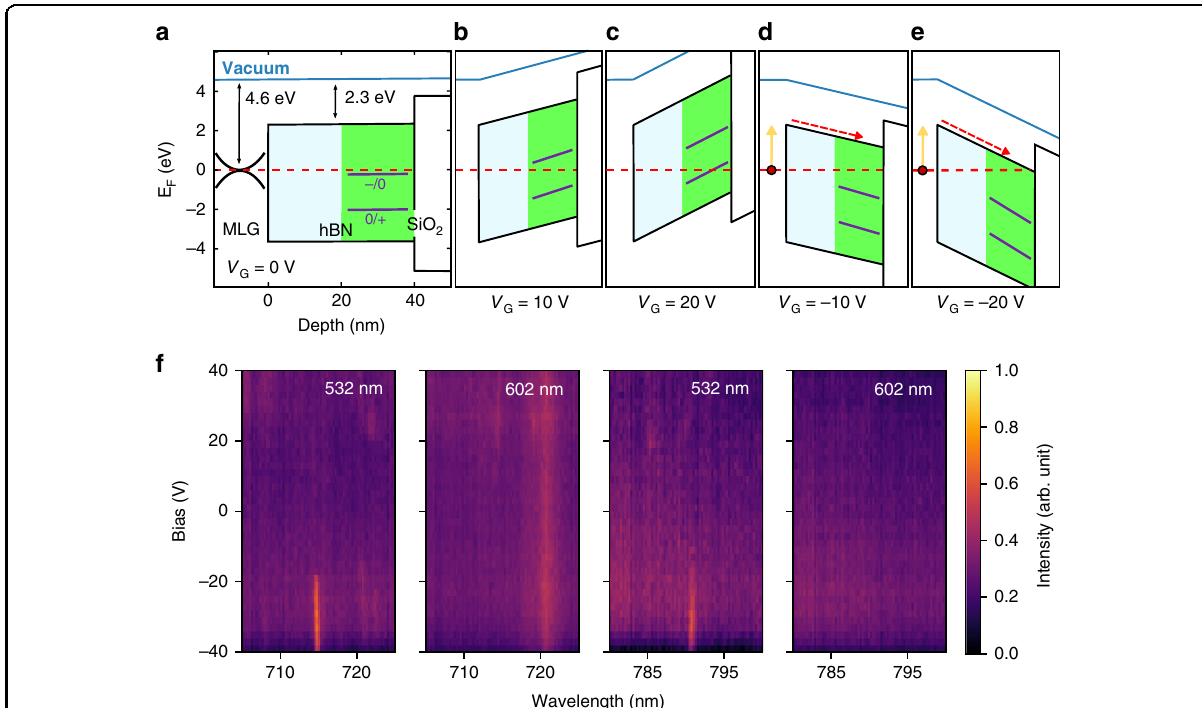
Fig. 4 Band diagram of the heterostructure device under various bias con fi gurations. a The device where both electrodes are grounded ( V G = 0 V). The hBN capping layer is shown in light blue and the hBN layer that contains quantum emitters is shown in green (the thickness of each hBN layer is assumed to be 20 nm). The MLG quasi-Fermi level ( E F ) extends into the hBN, indicating charge transfer between MLG and defect states in hBN (see text). The purple lines indicate two hypothetical charge transition levels of a single defect in hBN. b , c The device with a bias of + 10 V ( b ) and + 20 V ( c ) applied to the MLG electrode. d , e The device with a bias of − 10 V ( d ) and − 20 V ( e ) applied to the MLG electrode. The solid yellow arrows show photoexcitation of an electron in MLG, and broken red arrows indicate the drift of the electrons via the band gaps of the hBN layers. f Experimental veri fi cation of the model, whereby emitters (at ~715 nm and 790 nm) are only visible under green excitation ( λ exc = 532 nm) but not under lower energy red excitation ( λ exc = 602 nm), at the same confocal spot. The emission at 720 nm is graphene Raman